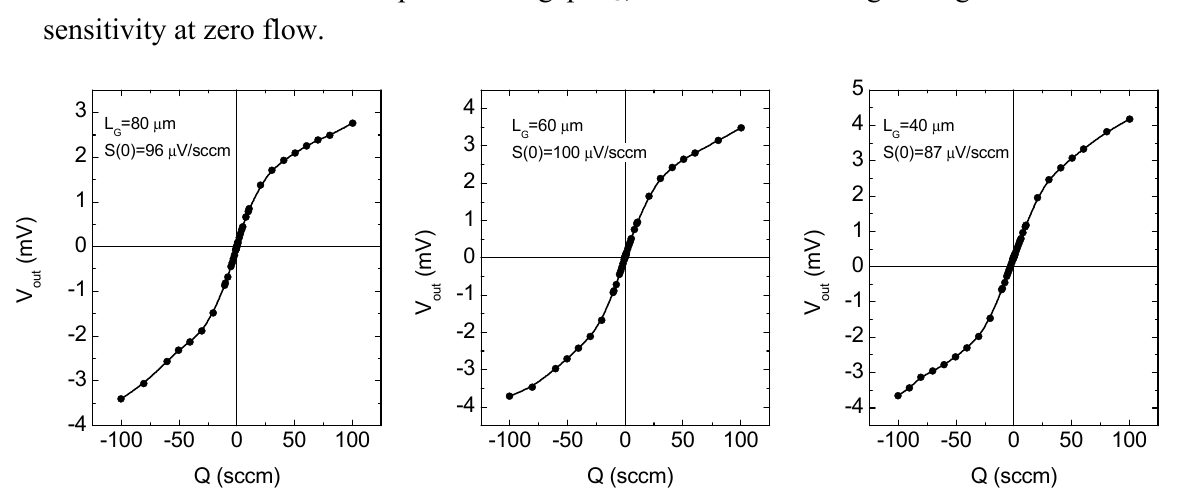
, indicated in the figure together with the G